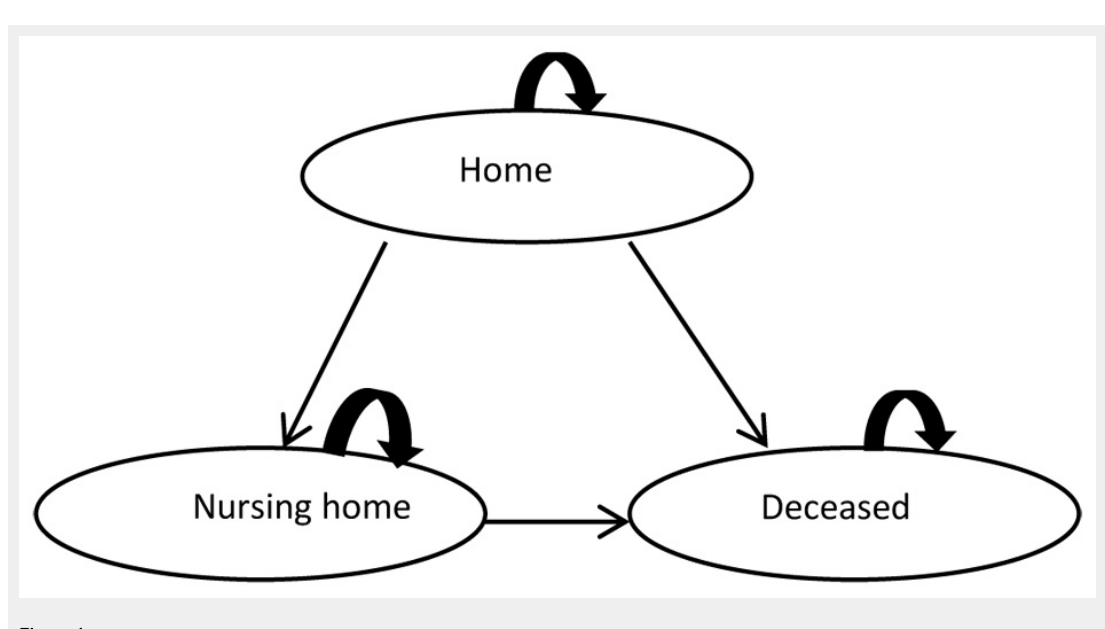
Figure 1 Structure of the Markov model from Lachaine et al. [23].